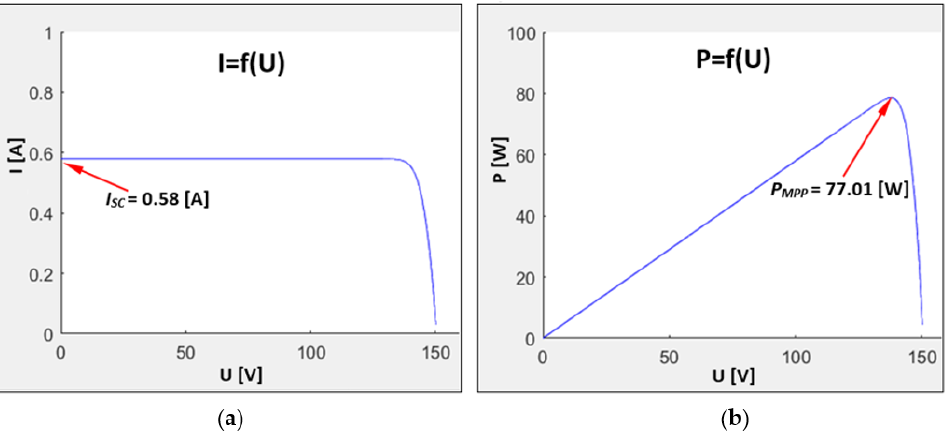
Figure 5. Simulation results for nominal parameters of CX-75/200 module: ( a ) current–voltage characteristic curve I = f(U); ( b ) power diagram P = f(U).